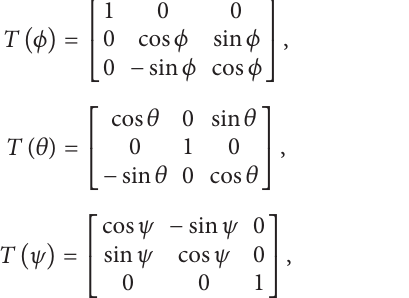
Table 1: Sea state parameters. Roll